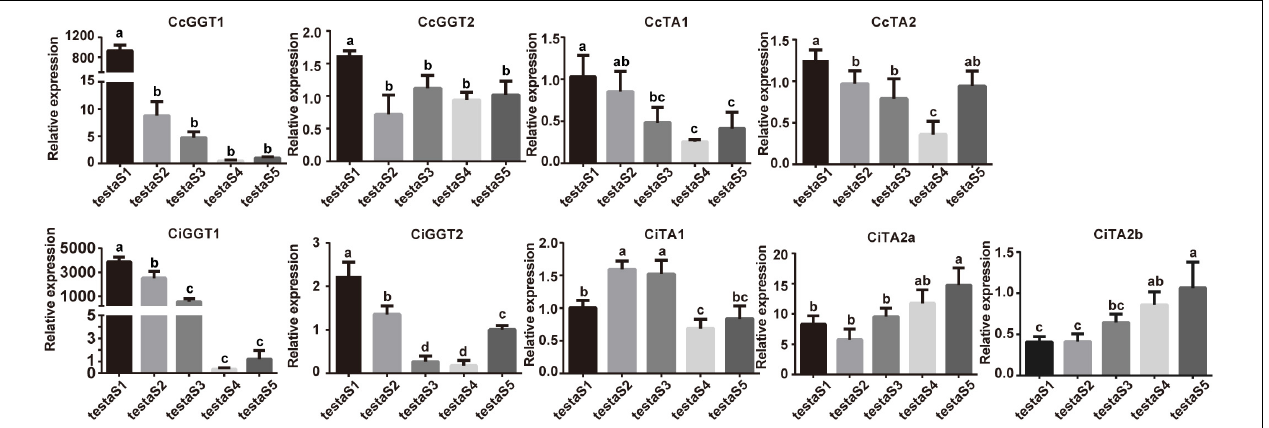
FIGURE 8 | Expression analysis of GGT and TA genes in seed coats in Chinese hickory and pecan by RT-qPCR. The analysis was performed using three biological replicates and three technical replicates for each sample. The error bars represented the standard deviations of nine replicates. Different letters indicated significant differences according to the Tukey–Kramer test ( P <